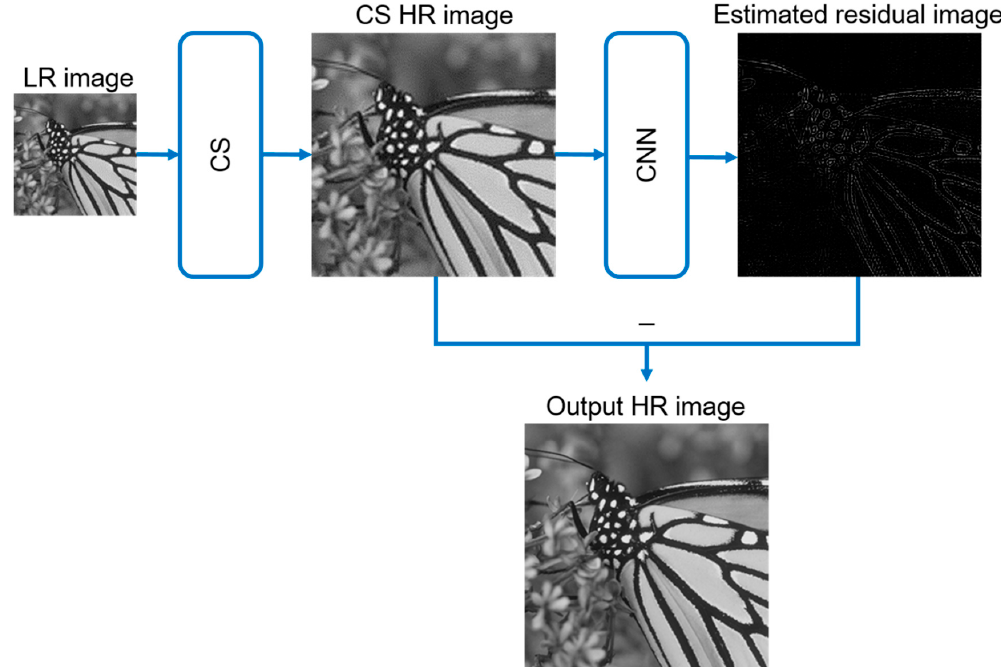
Figure 5. The whole architecture of the proposed SR method.